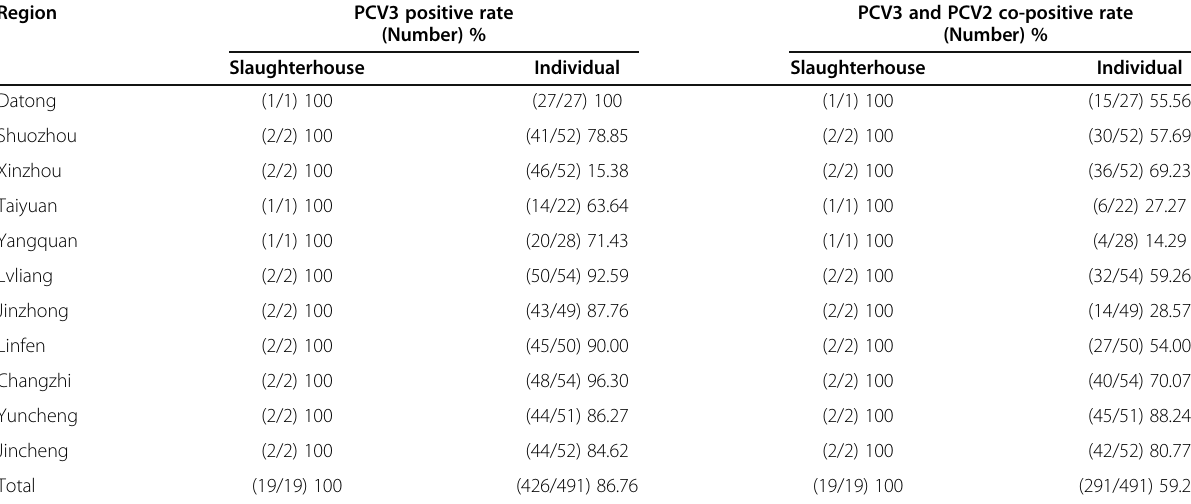
PCV3 and PCV2 co-positive rate (Number) %